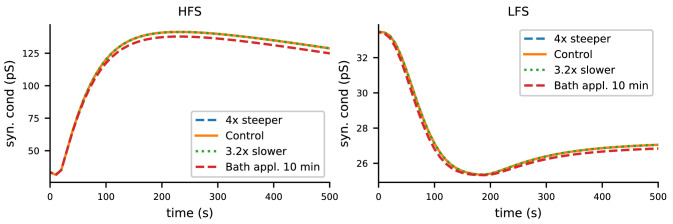
The biochemical signalling network model robustly predicts LTP for HFS and LTD for LTP with altered durations of neuromodulatory inputs.In the control case, the pre-synaptic input-associated fluxes of β-adrenergic and cholinergic ligands were 10 and 20 particles/ms, respectively, and the duration of each pulse was 3 ms. Here, the ligand inputs were made four times steeper by reducing the duration to 0.75 ms and the increasing the amplitudes to 40 (β-adrenergic) and 80 (cholinergic) particles/ms (blue), or 3.2 times less steep by increasing the duration to 9.6 ms and reducing the amplitudes to 3.125 (β-adrenergic) and 6.25 (cholinergic) particles/ms (green). Both alterations gave LTP and LTD responses that were indistinguishable from those of the control case. The red dashed line shows the LTP and LTD responses where the pre-synaptic input-associated fluxes of β-adrenergic and cholinergic ligands were replaced by a 10 min pulses of amplitudes 0.4 (β-adrenergic) and 0.8 (cholinergic) particles/ms, respectively, initiated 6 min prior to the pre-synaptic inputs to mimic the bath application of corresponding agents.